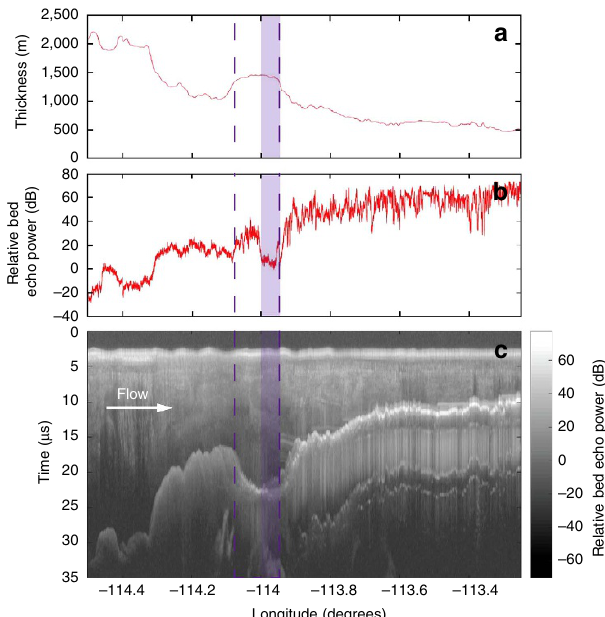
Figure 5 | Radar sounding data show evidence of an isolated area of grounding between two floating portions of the Kohler Glacier grounding zone. ( a ) Across a region of nearly constant ice thickness (dashed magenta lines), ( b ) the approximately 20dB drop in relative bed echo power is consistent with a basal interface transition from ocean water to bedrock 44,45 indicating that the glacier is grounded in the part of the profile delimited by the magenta rectangle. ( c ) A 2009 MCoRDS radargram of the Kohler Glacier grounding